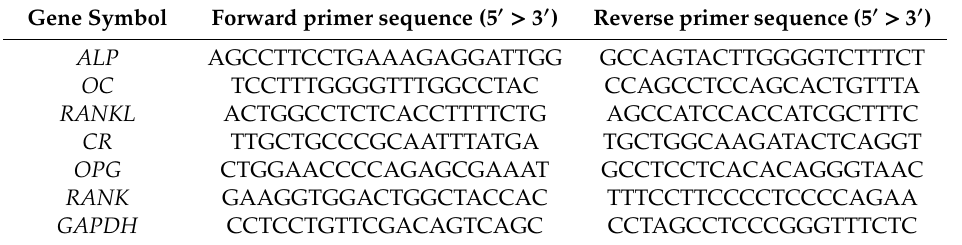
Table 1. Primer sequences for real-time polymerase chain